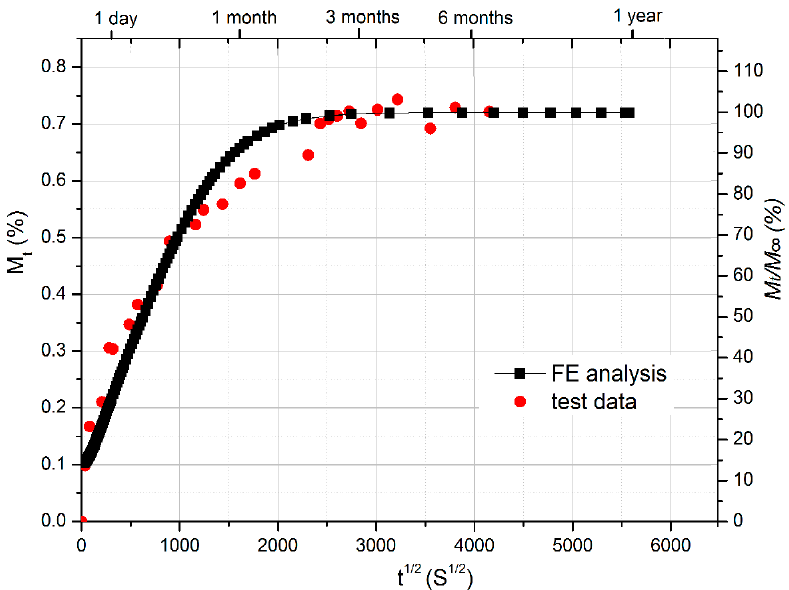
Figure 5. Comparison of moisture uptake curve between test results and finite element (FE) analysis on FRP specimens for short-beam shear tests.